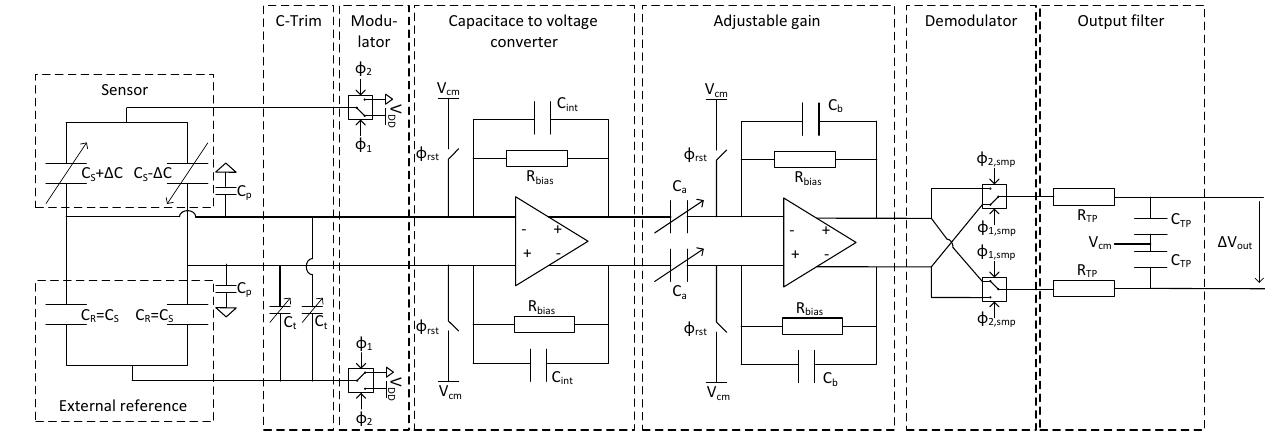
Figure 1. Block diagram of the presented circuit architecture.